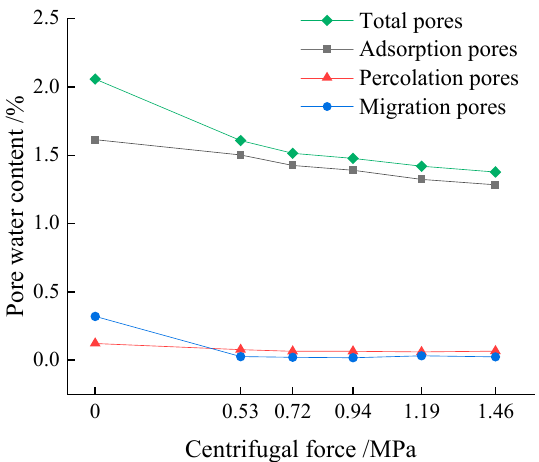
Figure 6. Relationship between centrifugal force and pore water content.